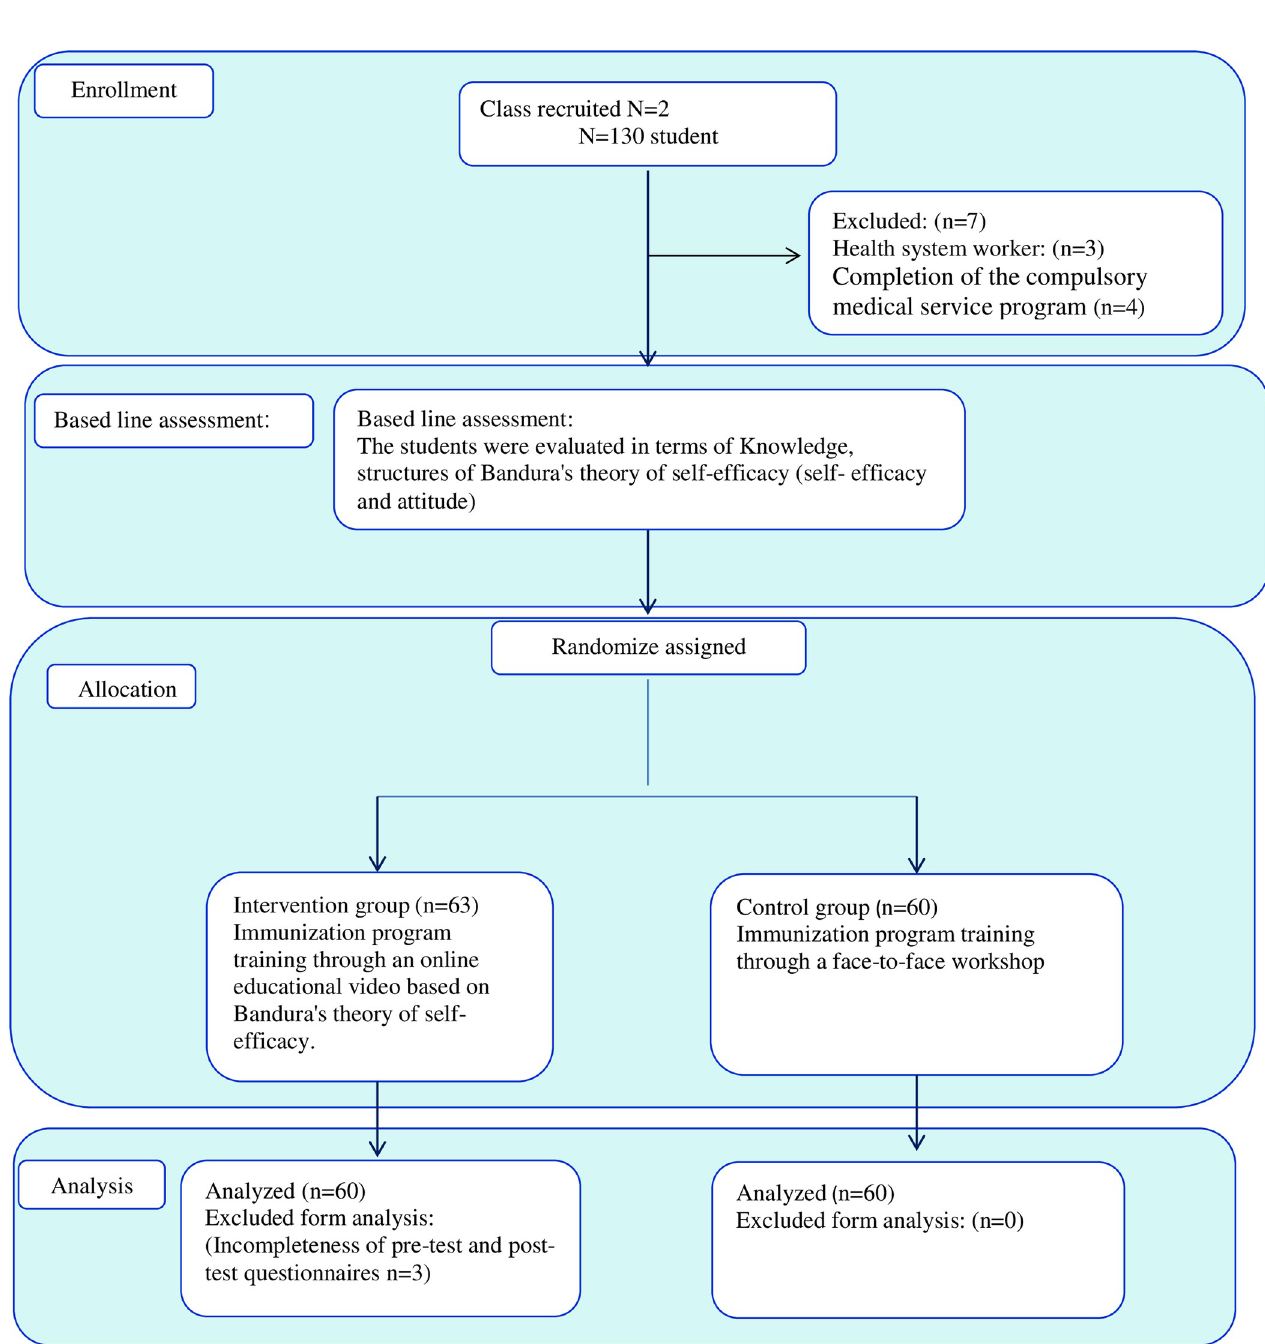
Fig 1. CONSORT flow diagram of participants throughout the